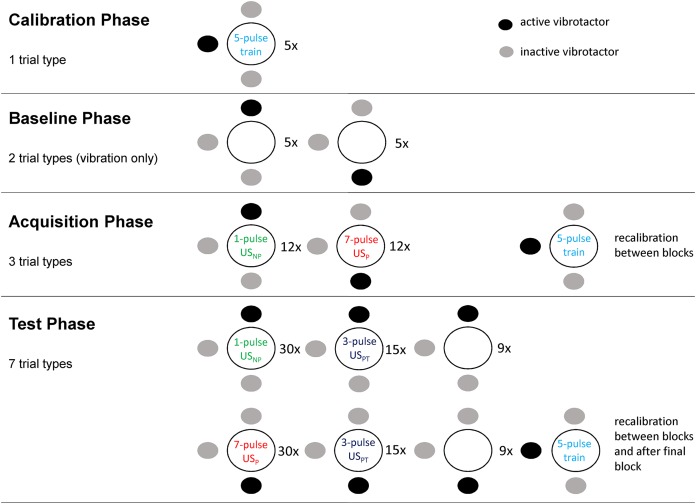
The four phases of the experimental procedure.Dots indicate vibrotactile stimuli, dark dots show which vibrotactor was activated for each trial type. Circles indicate the field on which the two electrodes were placed (adapted with permission from Madden et al. (2016a)).